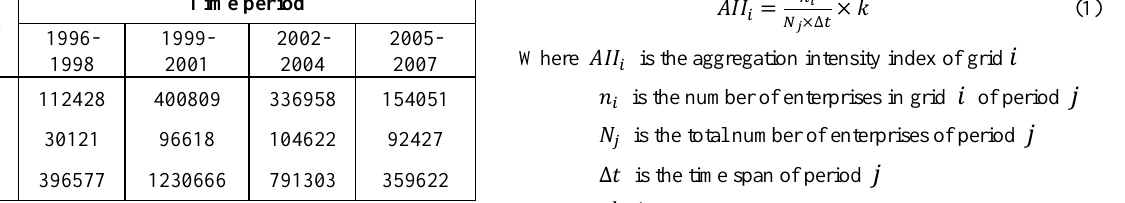
Table 1. Enterprise number entries of each 3-years-period between year 1996 to 2007(where HSSW denotes health and sports facilities and social welfare; SRCT denotes scientific research and comprehensive technical services; and WRC denotes wholesale and retail trade and catering)